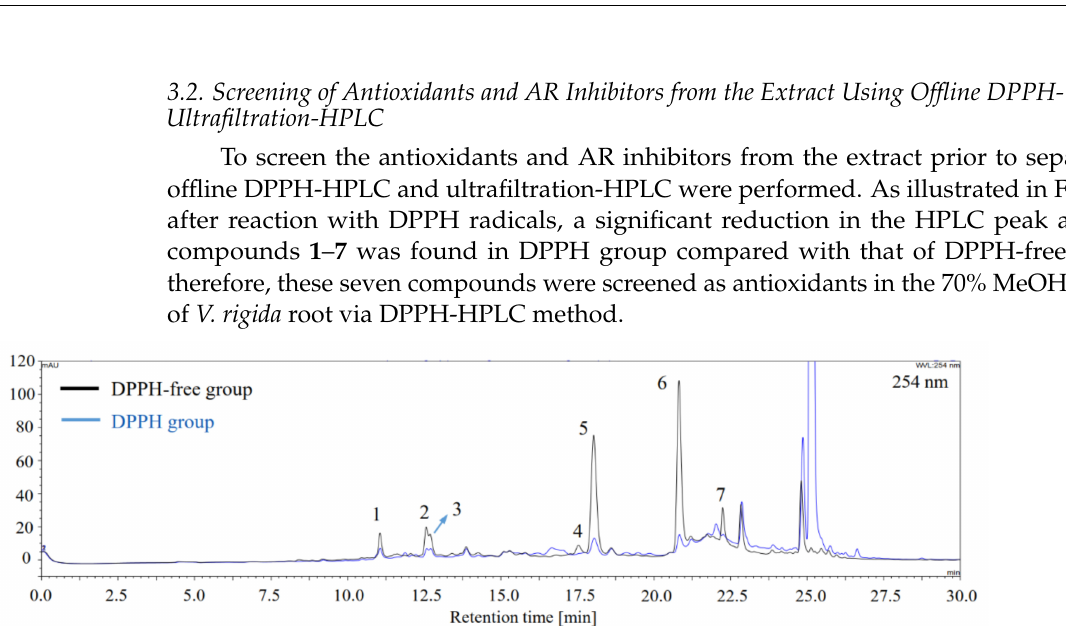
Figure 1. Chromatogram of DPPH-HPLC for screening antioxidants from the 70% MeOH extract of V. rigida root. Com- pounds 1 – 7 were identified as antioxidants via DPPH-HPLC, since the HPLC peak areas (254 nm) of these seven components reduced after reaction with DPPH radicals (DPPH group) compared with those from the DPPH-free